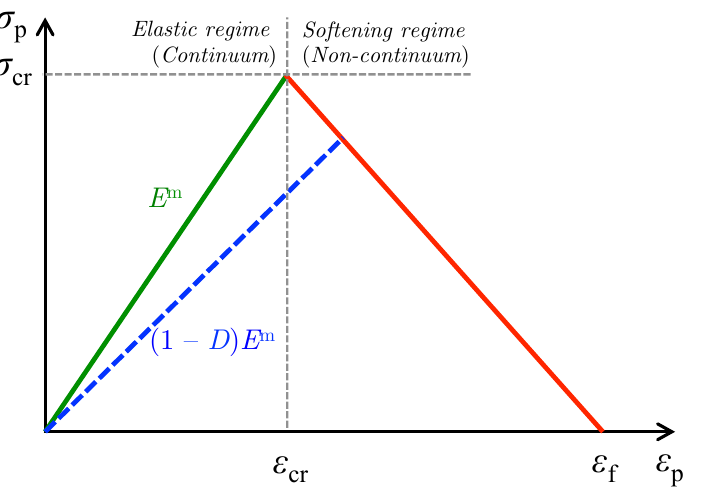
Figure 6. Crack band law in terms of maximum principal stress and maximum principal